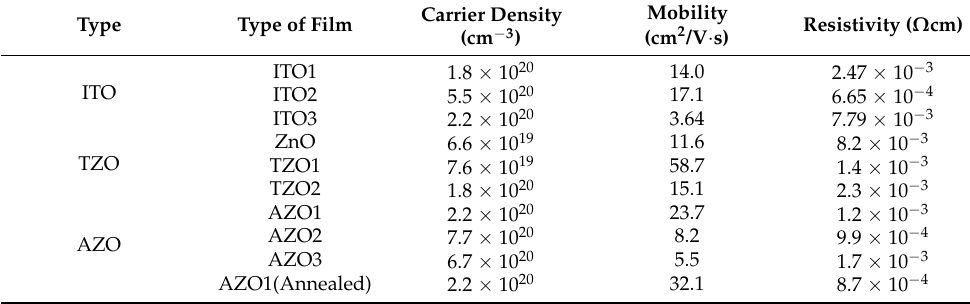
Table 2. The electrical properties of ZnO and TZO films. Adapted from Refs.